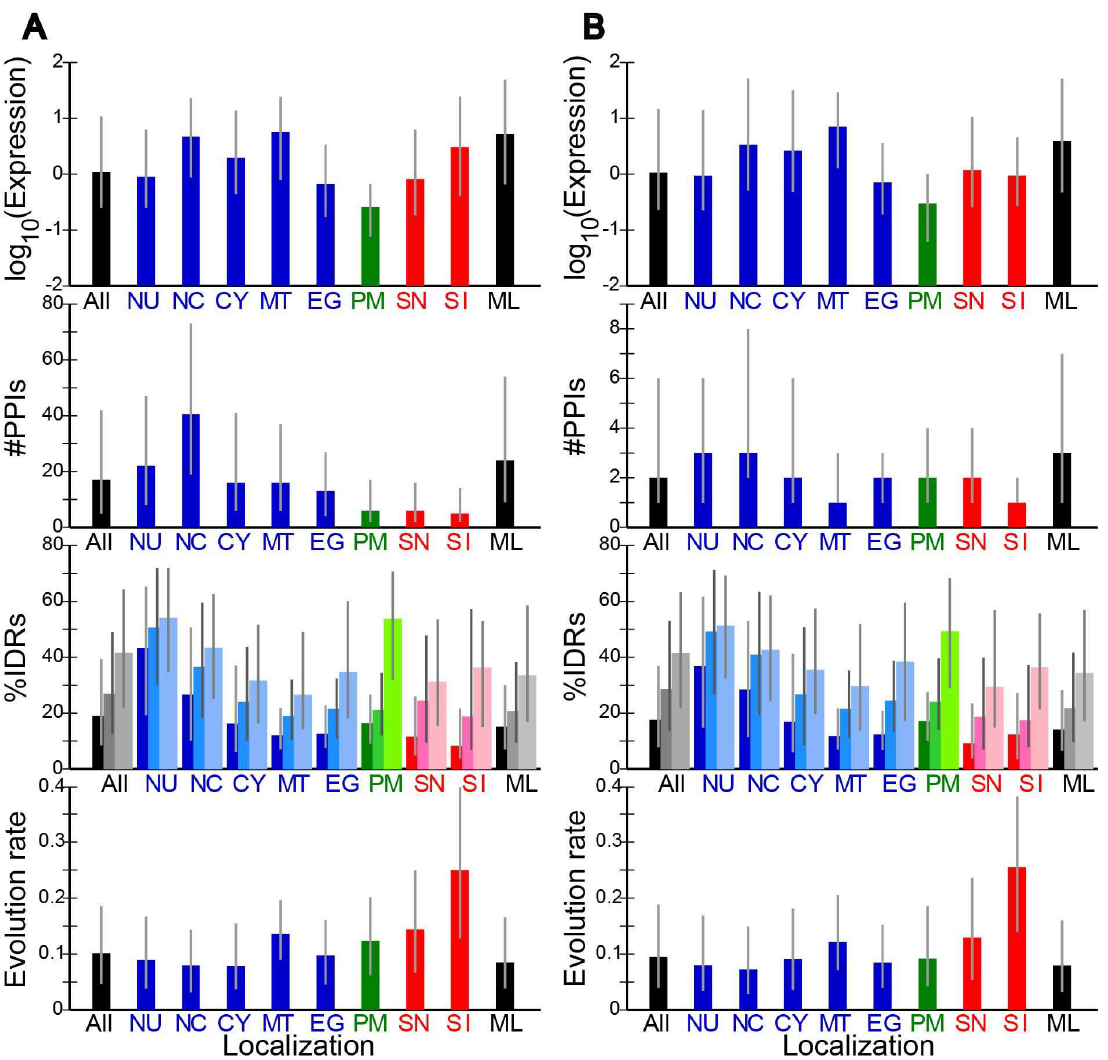
Figure 1. Medians and ranges of four quantities in different localizations in two mammals. ( A ) H. sapiens ; ( B ) M. musculus ; Rectangles in each panel from the bottom to the top represent the medians in evolution rate, fractional IDR content by DISOPRED (left), DICHOT (middle) and POODLE (right), the number of PPIs, and expression level. Grey vertical bars represent interquartile ranges, with their bottom and top corresponding to the 25th to the 75th percentile, respectively. The abbreviations for localizations are as in Table 1.